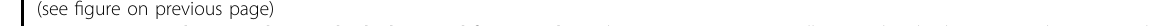
Fig. 1 CASK regulates insulin vesicle docking and fusion. a , b Insulin secretion in INS-1E cells treated with glucose or KCl. CASK was knocked down using two distinct siRNA fragments (Ri-1 or Ri-2). Non-silencing control siRNA (NC) was used as control. WT, wild type cells; Con, empty vector and NC siRNA transfected cells; Res, siRNA-resistant CASK. Western blotting showing the ef fi ciency of CASK knockdown and the expression levels of siRNA-resistant CASK. c Insulin secretion in KO islets. Left panel, fi xed islet sections were stained with anti-CASK (green), anti-insulin (red, β cells) and DAPI (DNA, blue). Right panel, insulin secretion in the isolated primary islets from the control mice with RIP-Cre and the CASK β -cell KO mice, respectively, stimulated with glucose and KCl. d Perifusion assay. Left panel, western blotting showing CASK expression levels in control and CASK-KO islets. Right panel, representative data (out of three experiments) showing that CASK-KO islets had impaired insulin secretion in the perifusion assay. e (i) Representative images from transmission electron micrograph showing the distribution of dense core vesicles in the control or CASK – depleted (CASK Ri-1) beta cells after glucose stimulation. An orange line was used to outline the cell membrane. Distances from yellow, purple and pink lines to cell membrane were 25 nm, 80 nm and 160 nm, respectively. Arrows and arrowheads indicate the vesicles located within 160 nm from the cell membrane and vesicles pinching off from the cell surface, respectively. (ii) Quanti fi cation of vesicle distribution after stimulation and total vesicle number in unstimulated cells were shown in right panels. (iii) In total, 13 samples of control islets and 18 samples of CASK – depleted islets were analyzed. f Insulin vesicle fusion induced by glucose/KCl in INS-1E cells. (i) bright- fi eld image of (ii). (ii) Maximum projections from a representative experiment recorded by TIRFM showing release events over the basal period (10 mins) and fi rst 10 mins of both the glucose and KCl stimulations. Scale bar, 50 μ M. (iii) average number of release events per minute per fi eld of view detected in control (NC) and CASK RNAi cells. (iv) average event magnitude (Area X Event Intensity) per minute per fi eld of view. Data are mean ± SEM of 4 independent experiments per condition with one fi eld of con fl uent cells per experiment (~200 cells per fi